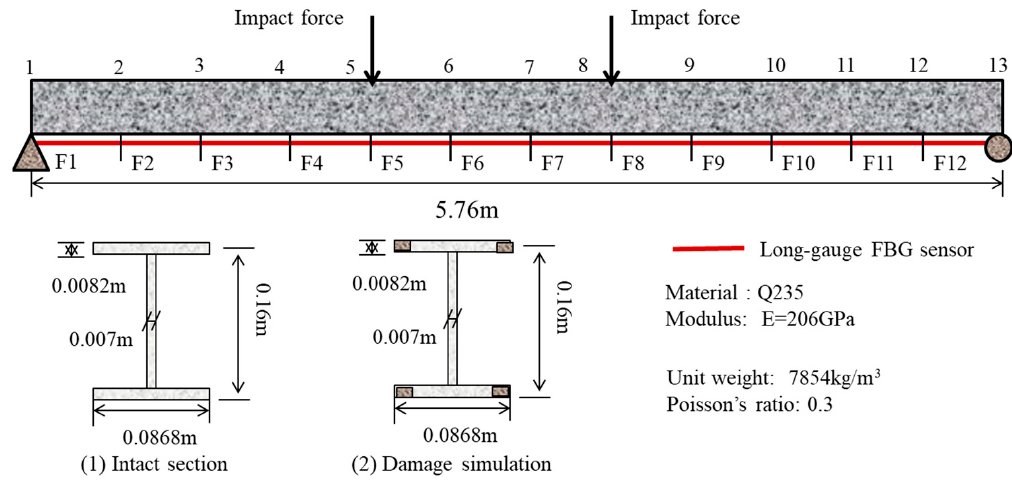
Figure 3. Configuration of the steel beam.